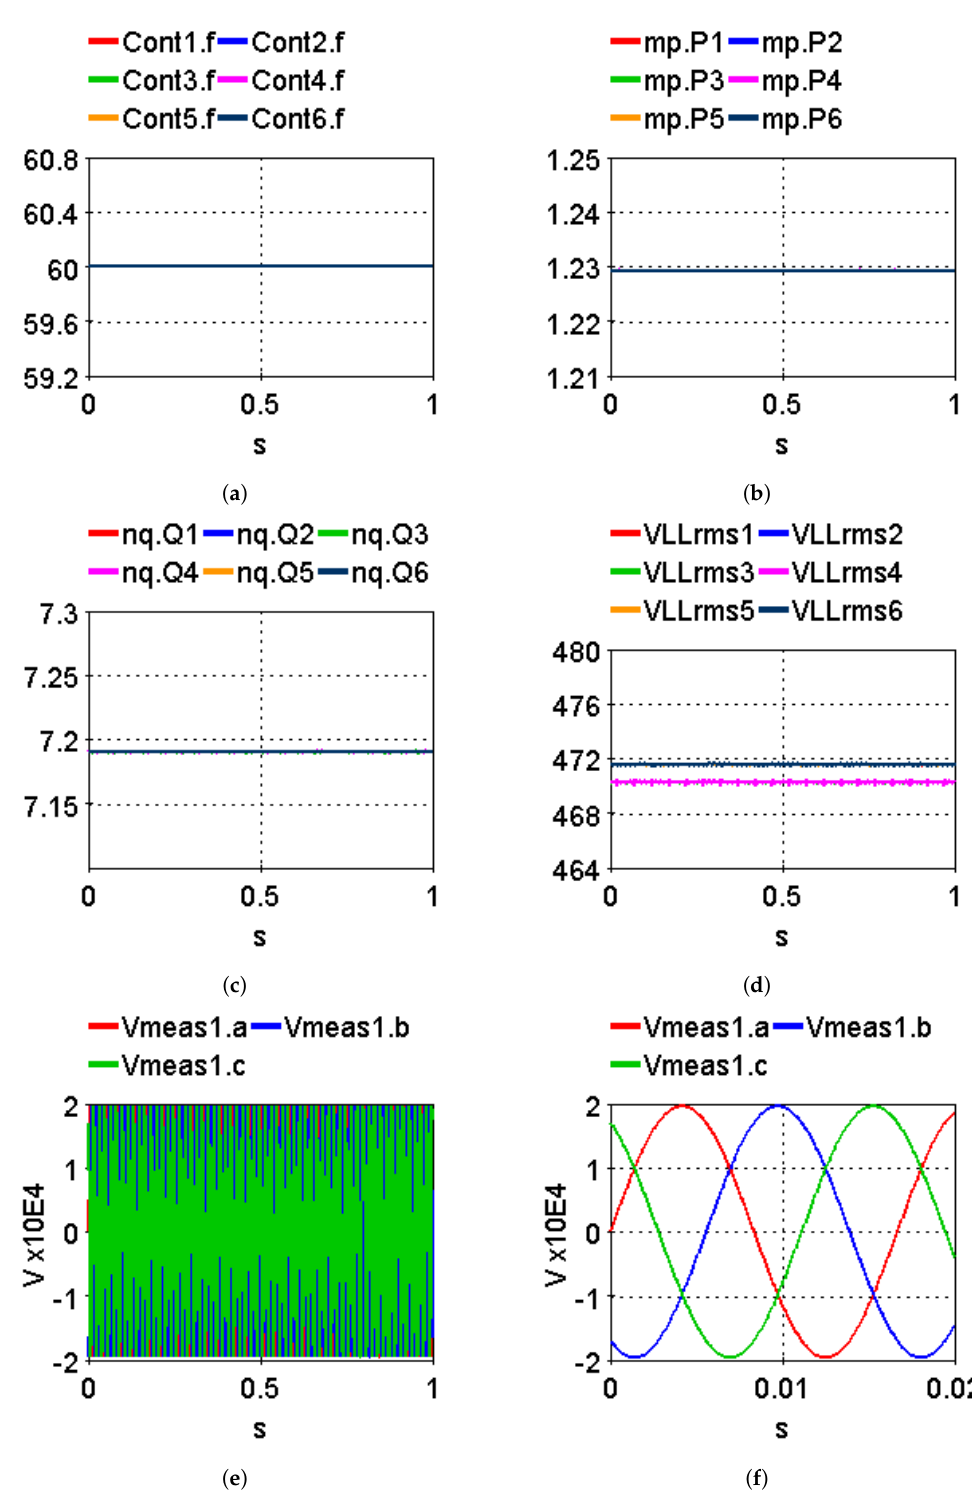
Figure 19. Real-time simulation results in HYPERSIM with respect to time (s): ( a ) frequency restora- tion (frequency (Hz)); ( b ) proportional active power sharing; ( c ) proportional reactive power sharing; ( d ) RMS values of V abc o (V); ( e ) voltage at B1 (V); and ( f ) zoomed version of ( e